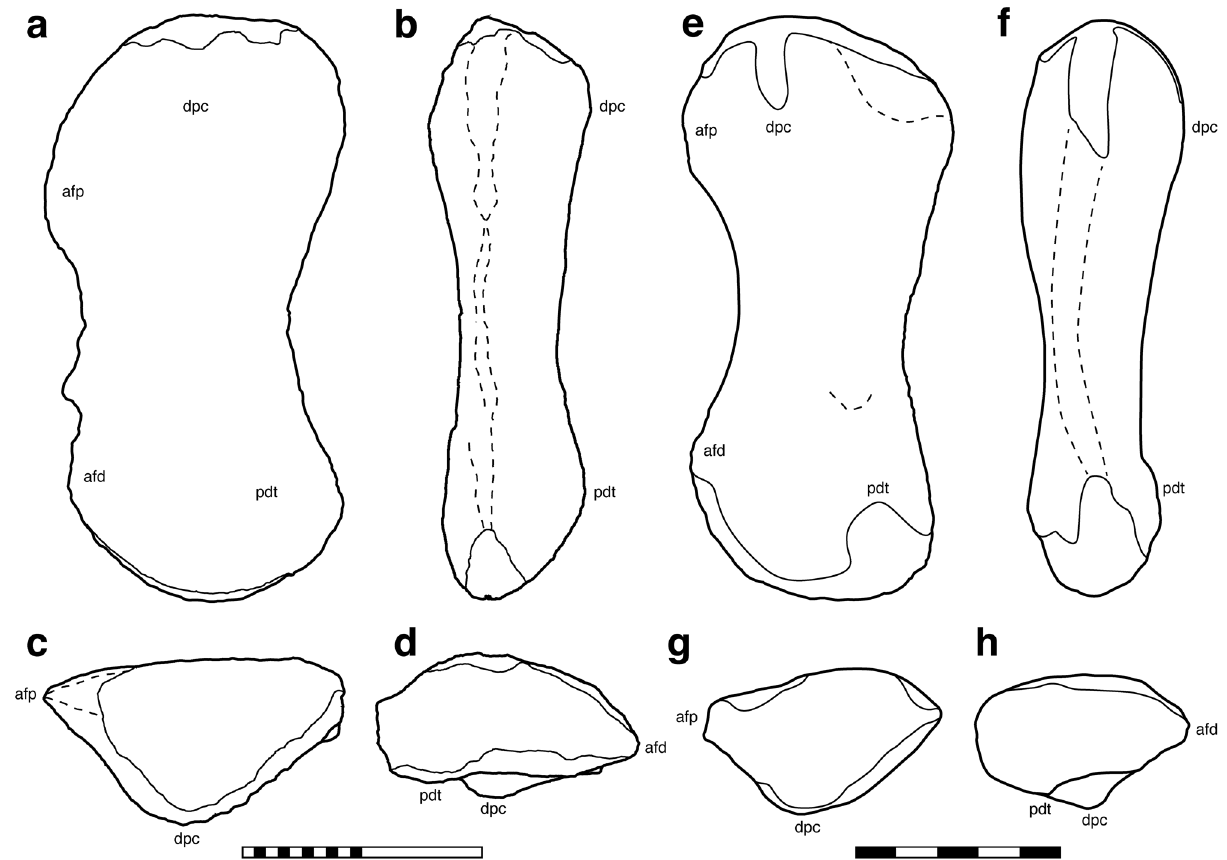
Figure 6. Comparison of humeri in two Triassic ichthyopterygians. ( a–d ) Right humerus of Cymbospondylus youngorum LACM DI 157871 in ( a ) ventral, ( b ) anterior, ( c ) proximal, and ( d ) distal views. ( e–h ) Ichthyopterygia gen. et sp. indet. NSM PV 24995 in ( e ) ventral, ( b ) anterior, ( c ) proximal, and ( d ) distal views. Bone contour (thick solid lines), boundary between periosteal and endosteal bones (thin solid lines) and distinct ridges (broken lines) are indicated. Scale bars equal 20 cm in ( a–d ) and 50 mm in ( e–h ). afd distal part of anterior flange, afp proximal part of anterior flange, dpc deltopectoral crest, pdt postero-distal